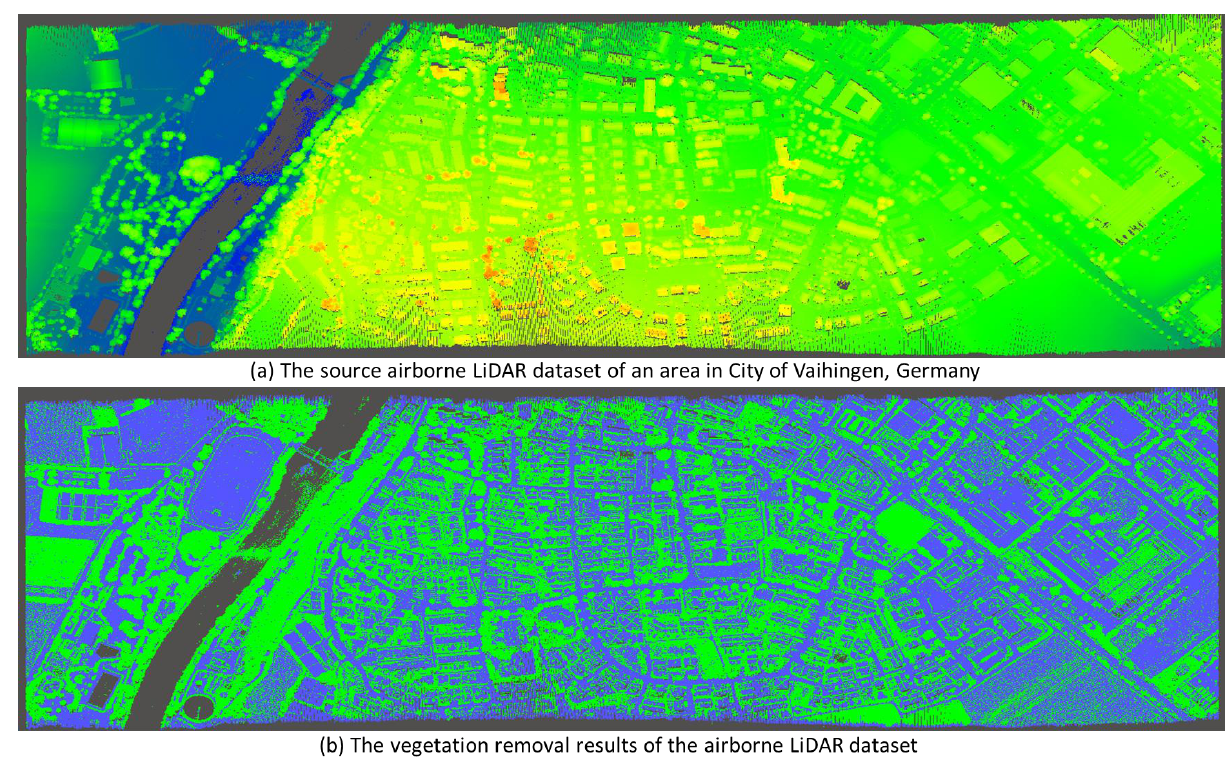
Figure 9. The overall vegetation removal results of the airborne LiDAR dataset.